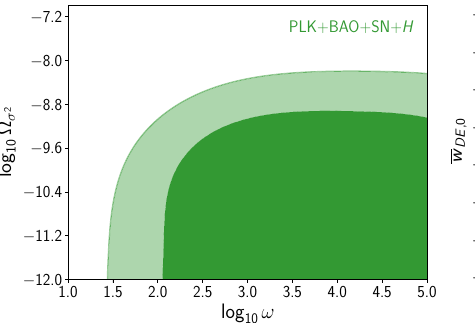
and 2 σ confidence contours. (Right panel): the 3D posterior distribu- tion in the { ¯ w DE , 0 , (cid:8)w DE , 0 , log 10 ω } subspace, where the colour code indicates the value of log 10 ω using the colour bar